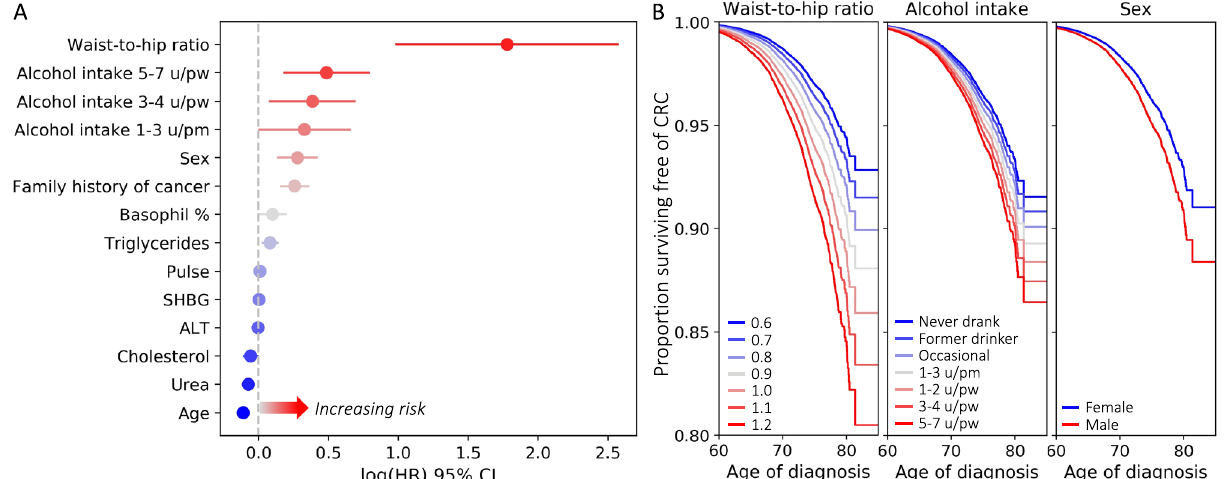
Figure 3. ( A ) Results of time-to-event analysis showing log hazard ratios and standard error of each variable included in the final optimal model. Log hazard ratios above 0 indicate an increased risk for CRC. Whereas values below 0 indicate a decreased risk (i.e., protective effect) for CRC. ( B ) Partial effects plots for the top 3 risk factors given the model, y axis displaying the proportion of participants who did not develop CRC. Note that the rate of decline in proportion of healthy individuals is faster for participants with waist-to-hip ratio of 1.2, those who drink 5–7 units of alcohol per week and males. CI confidence interval, HR hazard ratio, pm per month, pw per week, u units.